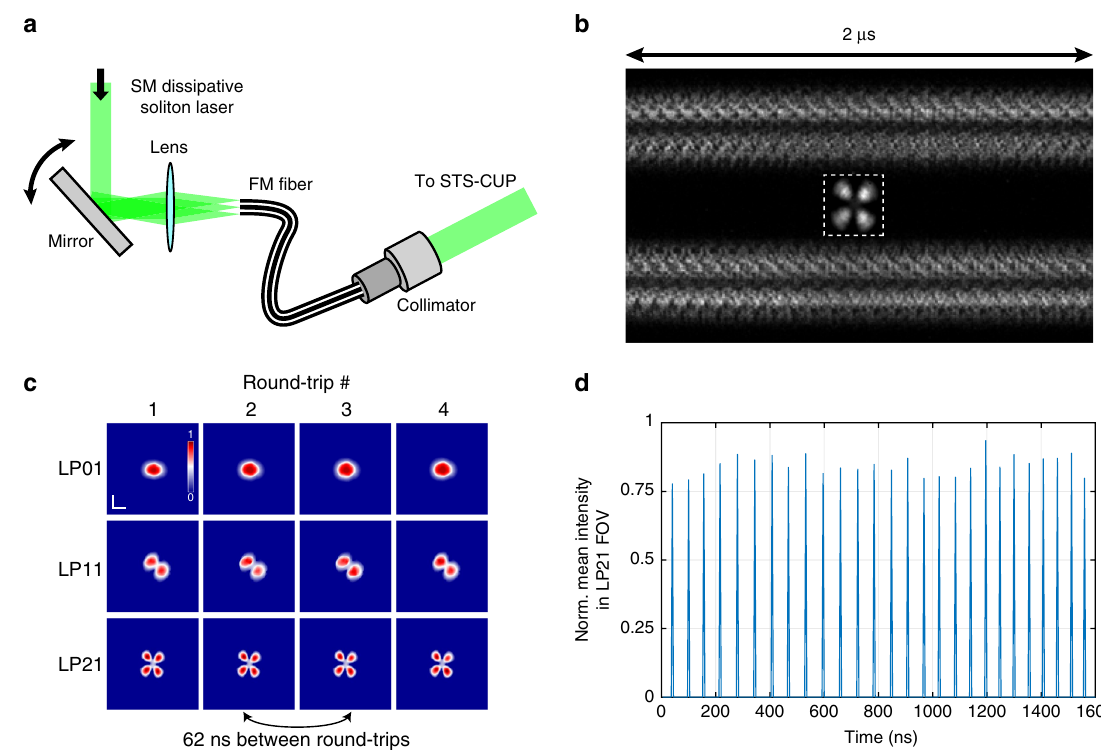
Fig. 2 Generation and single-shot capture of stable linear polarization modes. a Schematic for generating stable LP (linear polarization) modes using single-mode DSs. The output from a SM (single mode) DS mode-locked fi ber laser was coupled into a piece of FM (few mode) fi ber (~1 m in length) using a scanning mirror and focusing lens. Changing the angle of the scanning mirror could excite different higher-order LP modes, which were then collimated and sent through the RTP channel for STS-CUP imaging. b Representative raw STS-CUP data acquired at a speed of 1 billion frames per second. Two horizontal bands of temporally sheared signal are the complementary views of a multimode DS train with LP21 spatial pro fi le. The inset (dashed box) shows the corresponding temporally integrated image of the same multimode DS train captured by an external CCD camera. c Normalized round-trip DSs in LP01, LP11, and LP21 modes imaged by STS-CUP. Scale bar is 400 µ m. d Normalized spatial mean intensity of the reconstructed STS-CUP images vs time plot of the reconstructed LP21 data set. The period of the reconstructed DS train is 62 ns, in excellent agreement with the round-trip time of the single-mode DS laser measured using a fast